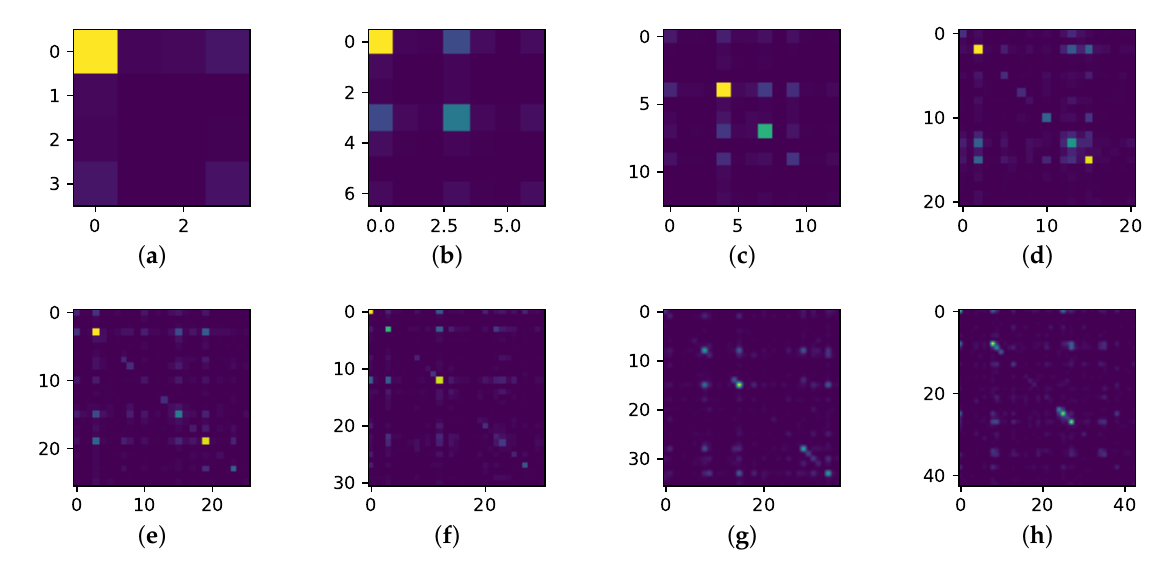
Figure 6. Transitions matrices for the different automata, where the axis labels identify each trim primitive, and brighter colours signify a higher number of occurrences of the corresponding transition in the data: ( a ) 4 trims; ( b ) 7 trims; ( c ) 13 trims; ( d ) 21 trims; ( e ) 26 trims; ( f ) 31 trims; ( g ) 36 trims; ( h ) 43 trims.